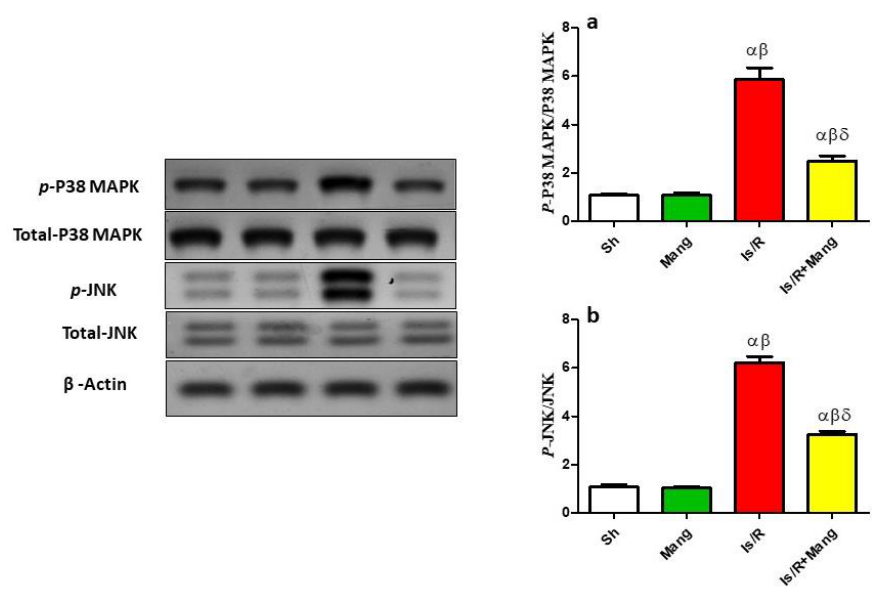
Figure 5. Mang’s (20 mg/kg, i.p) impact on renal ( a ) p -p38 MAPK, ( b ) p -JNK protein expression as signaling molecules. Data were articulated as the mean ( n = 7) ± SD, p value < 0.05 is significant. As compared with sham ( α ), Mang ( β ), and Is/R ( δ ) treated groups.